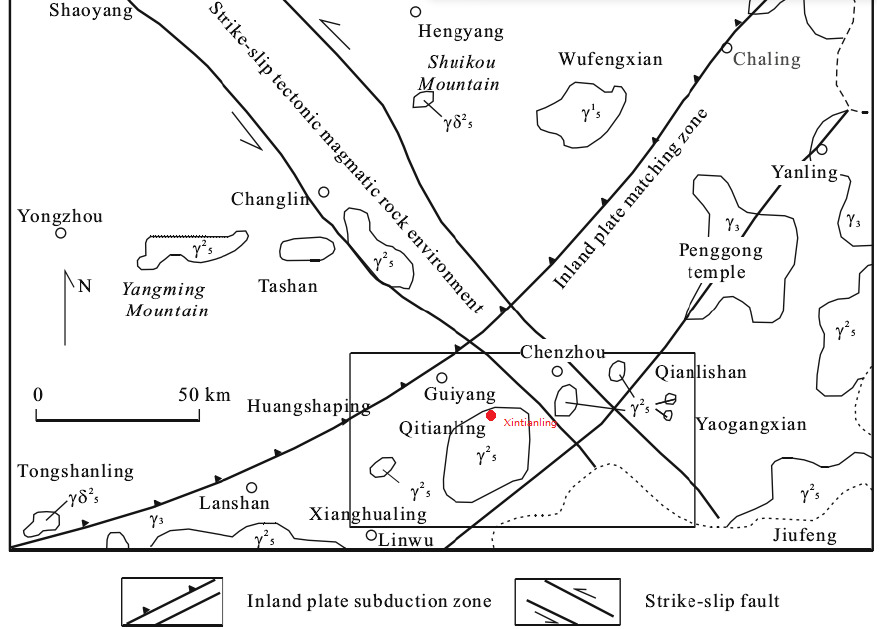
Figure 2. Tectonic setting of the Qianlishan–Qitianling area [7]. ( γ 3 .: Caledonian magmatic rock; γ 15 : Indo-Chinese epoch magmatic rock; γ 25 : Yanshanian magmatic rock; γδ 25 : Yanshanian granodiorite). Indo-Chinese epoch magmatic rock; γ 2 5 : Yanshanian magmatic rock; γδ 2 5 : Yanshanian